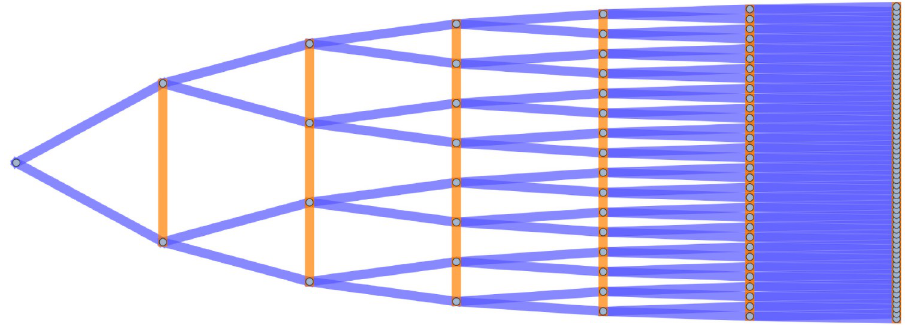
Fig 1. The first seven levels of the graph lineage of path graphs, with ancestry relationships. Δ l = 0 edges are colored in orange, Δ l = ± 1 edges are colored in blue. Self-loops are not illustrated.